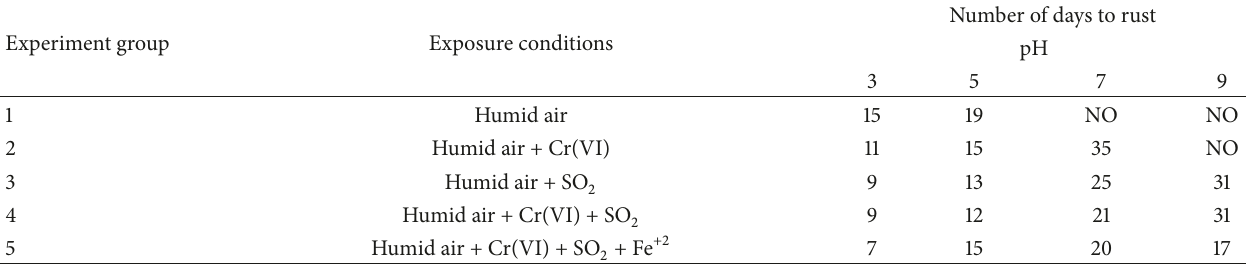
Table 1: Number of days required for the formation of corrosion products (rust) under different laboratory exposure conditions. Experiment group